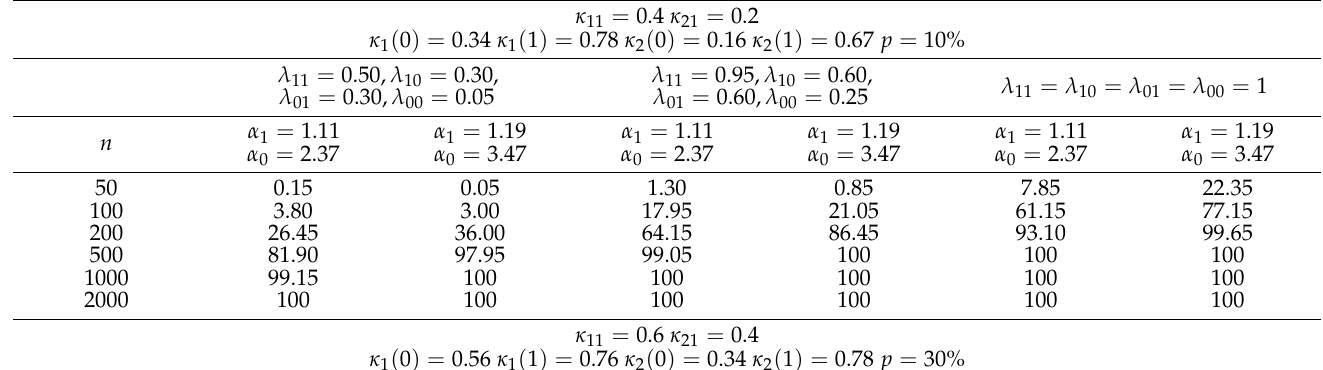
Table 5. Power (in %) of the hypothesis test when L (cid:48) > L (0 ≤ c < 0.5).